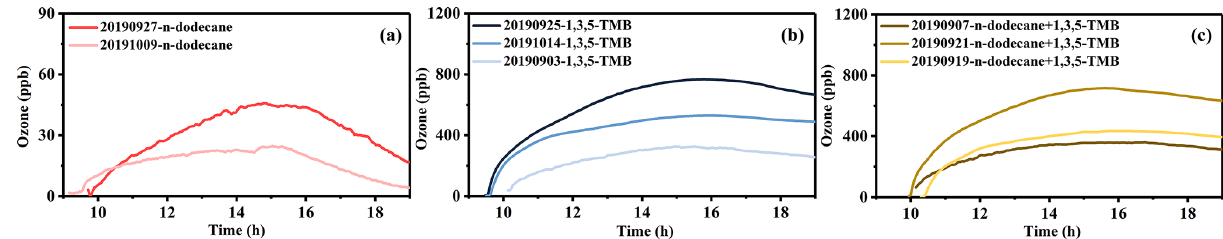
Figure 7. Ozone formation during the photochemical processes of n -dodecane (a) , 1,3,5-TMB (b) , and mixed AVOCs (c) .